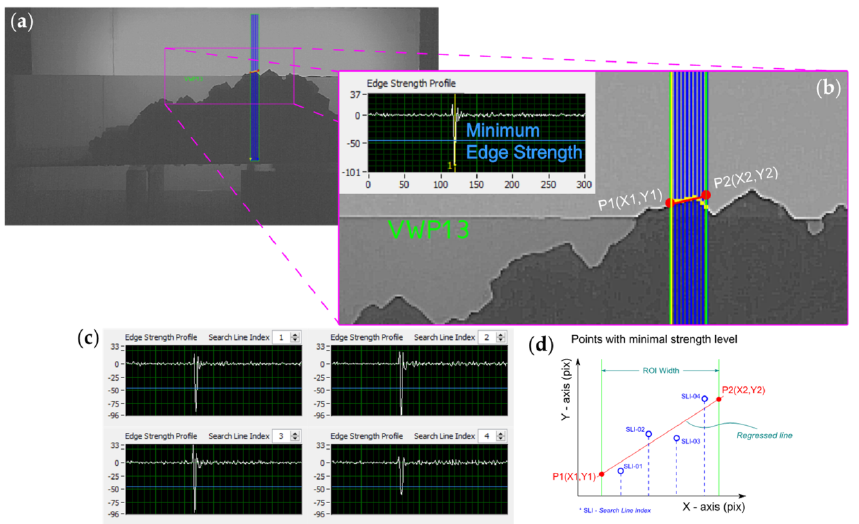
Figure A1. Sketch that illustrates the level measurement procedure for the 13th region of interest (ROI): ( a ) typical frame and definition of the 13th ROI; ( b ) search lines (in blue) defined inside the ROI; ( c ) edge strength profiles of some search lines; ( d ) definition of the virtual level inside the ROI, which corresponds to a regression line of the search line index